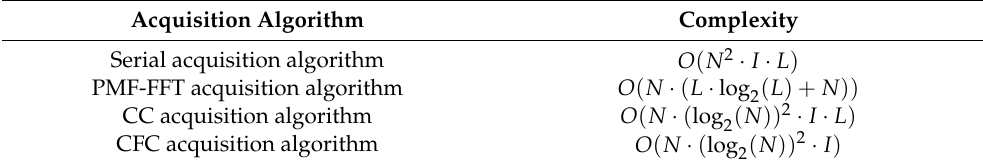
Table 1. Table of algorithm complexities. Acquisition